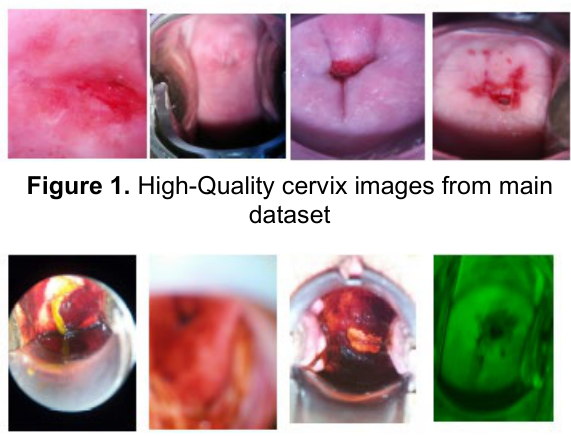
Figure 2. Low-Quality cervix images from the additional